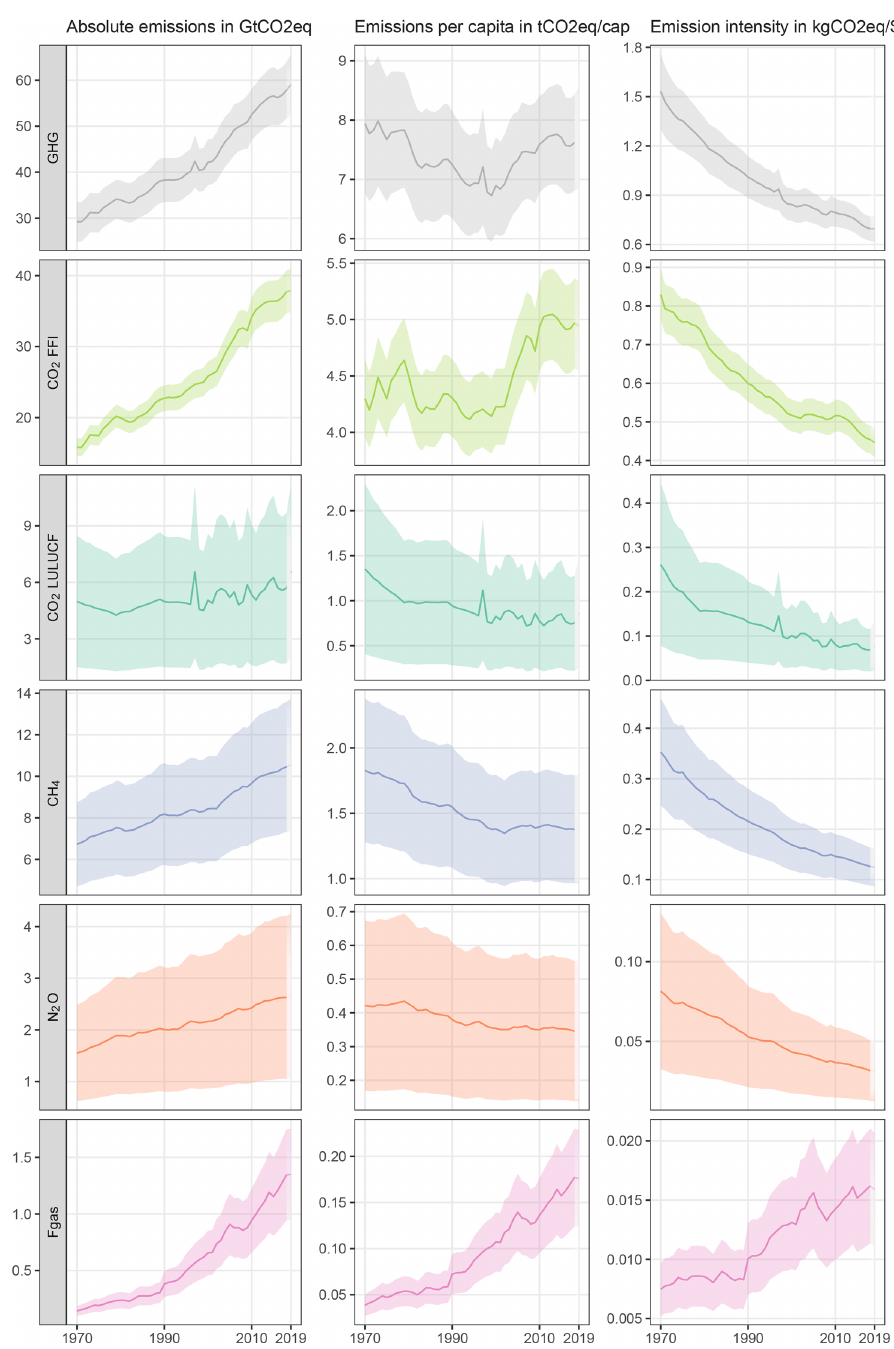
Figure 5. Global GHG emissions trends for 1970–2019 by individual (groups of) gases and in aggregate: GHGs (black); CO 2 -FFI (light green); CO 2 -LULUCF (dark green); CH 4 (blue); N 2 O (orange); fluorinated gases (pink). Aggregate GHG emissions trends by groups of gases reported in GtCO 2 eq . converted based on global warming potentials with a 100-year time horizon (GWP-100) from IPCC AR6 (Forster et al., 2021). Coloured shadings show the associated uncertainties at a 90% confidence interval without considering uncertainties in GDP and population data (see below). The first column shows emissions trends in absolute levels (GtCO 2 eq . yr − 1 ). The second column shows per capita emissions trends (tCO 2 eq./cap) using UN population data for normalization (World Bank, 2021). The third column shows emissions trends per unit of GDP (kgCO 2 eq./USD) using GDP data in constant USD2010 from the World Bank for normalization (World Bank,